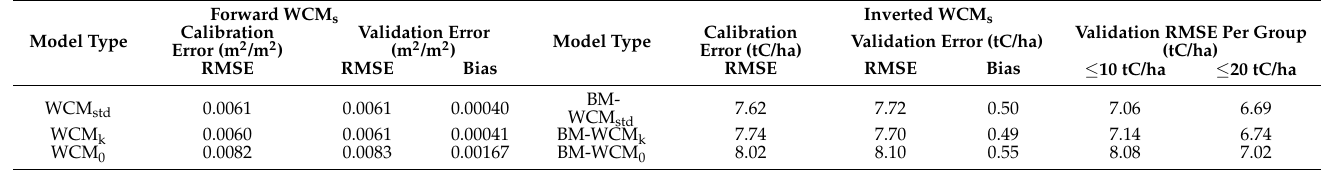
Table 3. Calibration and validation error of forward WCM s and inverted WCM s